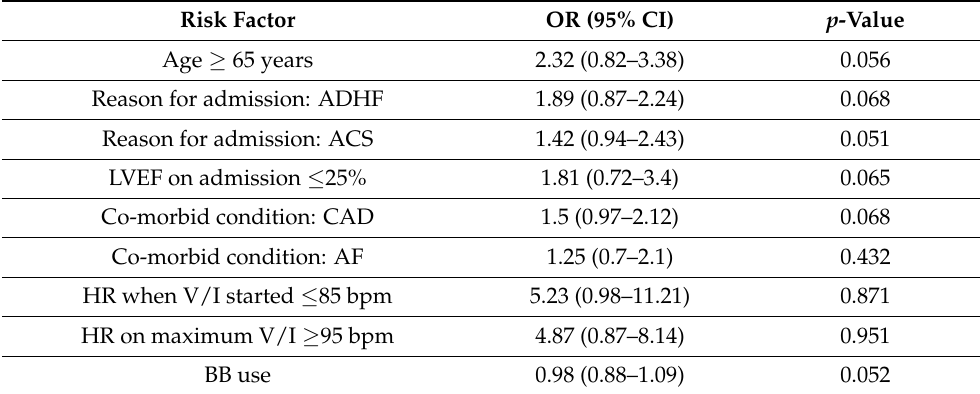
Table 3. Multivariable logistic regression of predictors for in-hospitality